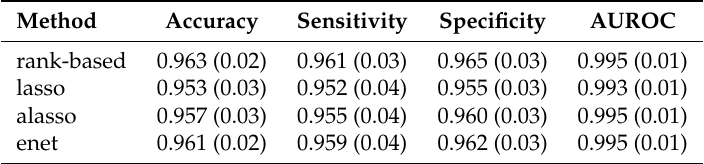
Table 2. Comparison of the performance among the four methods over 200 replications under simulation scenario 1. The values in parentheseses are the standard deviations.